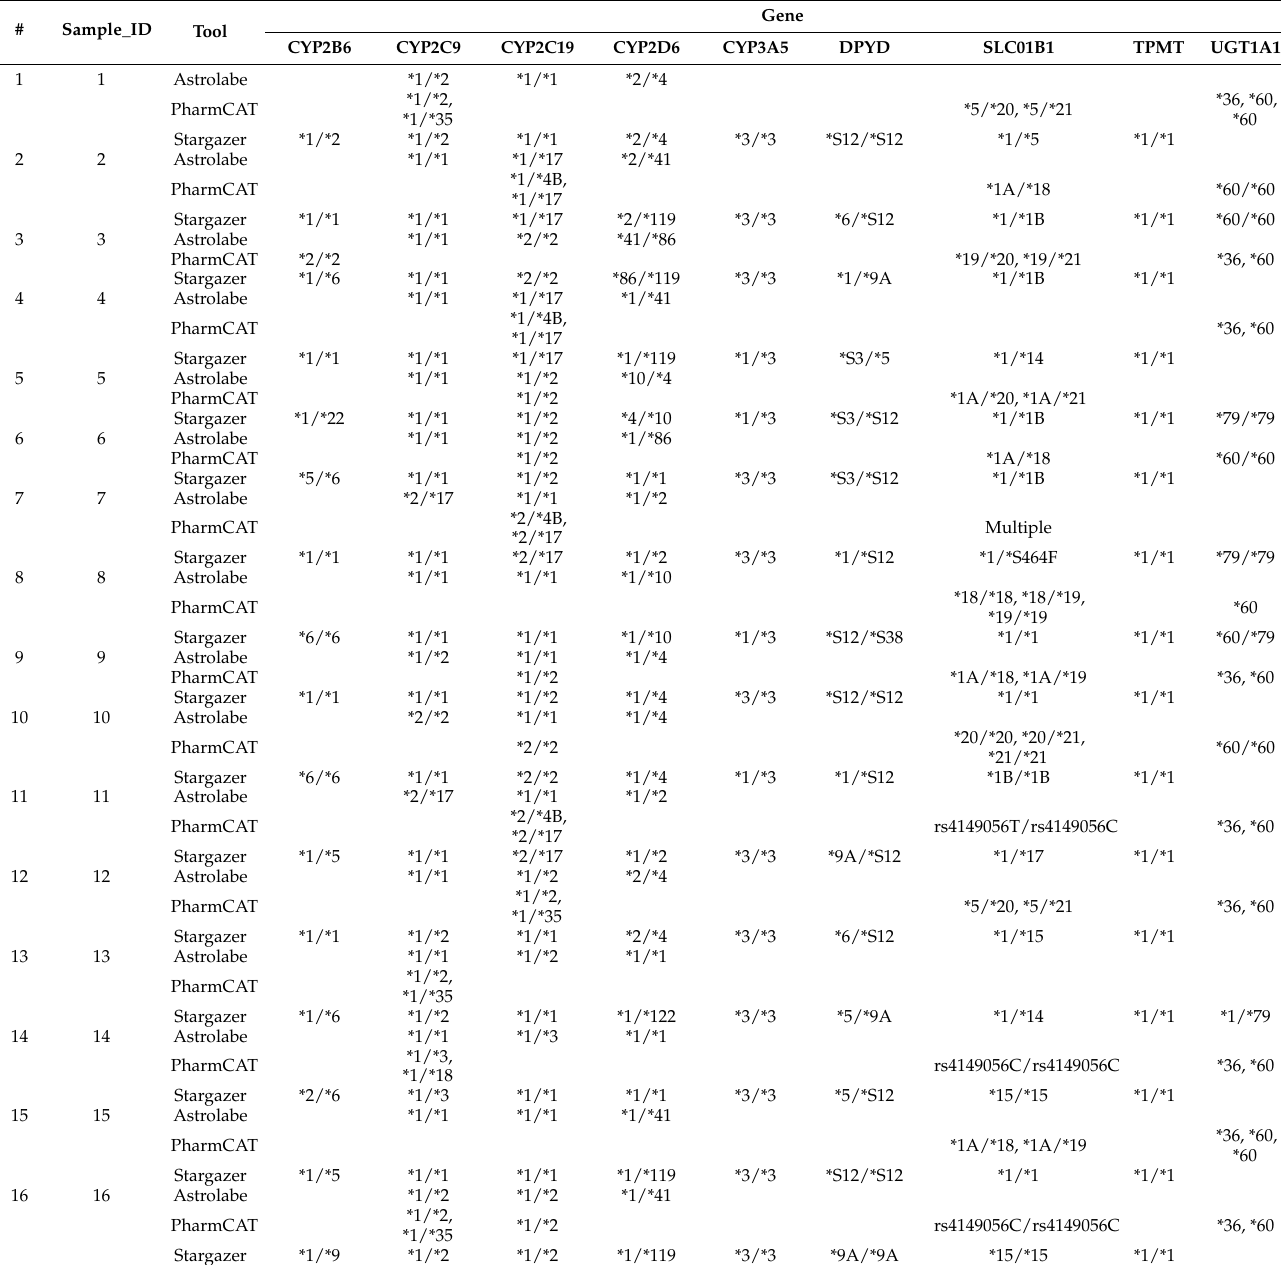
Table 2. Comparison of diplotype detected in the nine pharmacogenes using Astrolabe, PharmCAT and Stargazer in 20 whole genome sequencing (WGS)